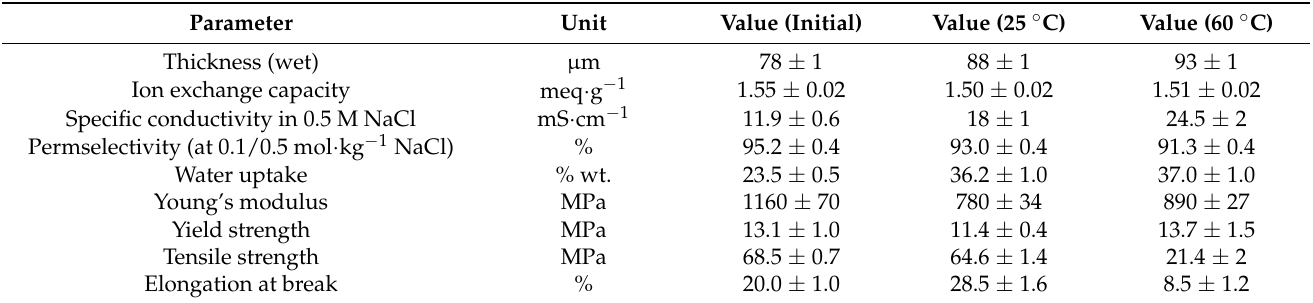
Table 4. Physical and chemical parameters of Fumasep ® FAD-75 in Cl − form.